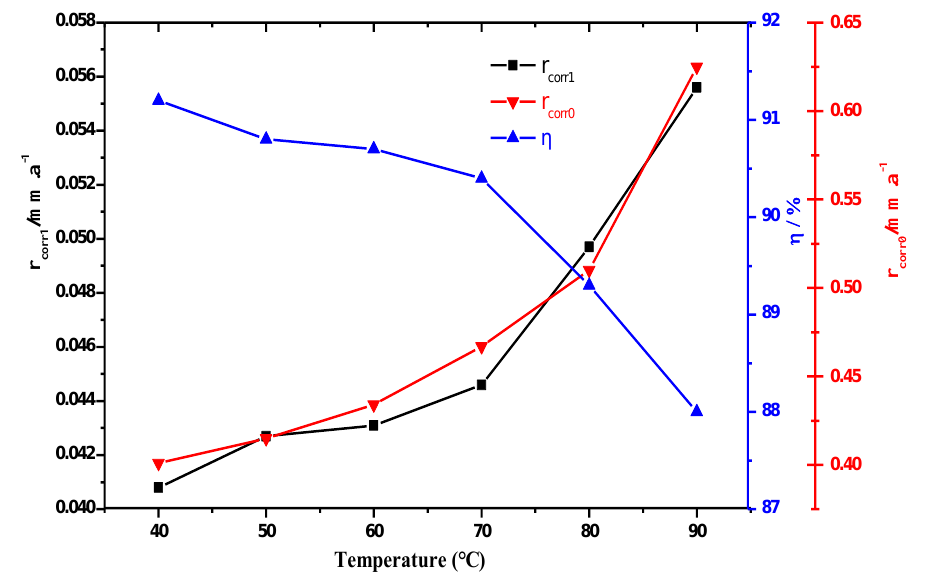
Figure 4. Evaluation of temperature on corrosion rate and corrosion inhibition rate.